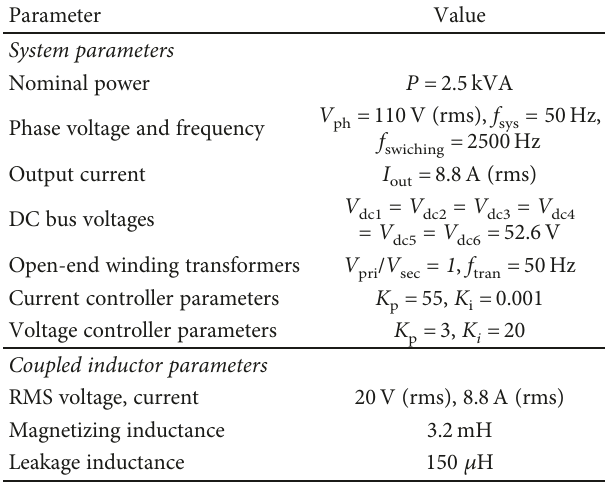
Table 2: General data of the proposed system.